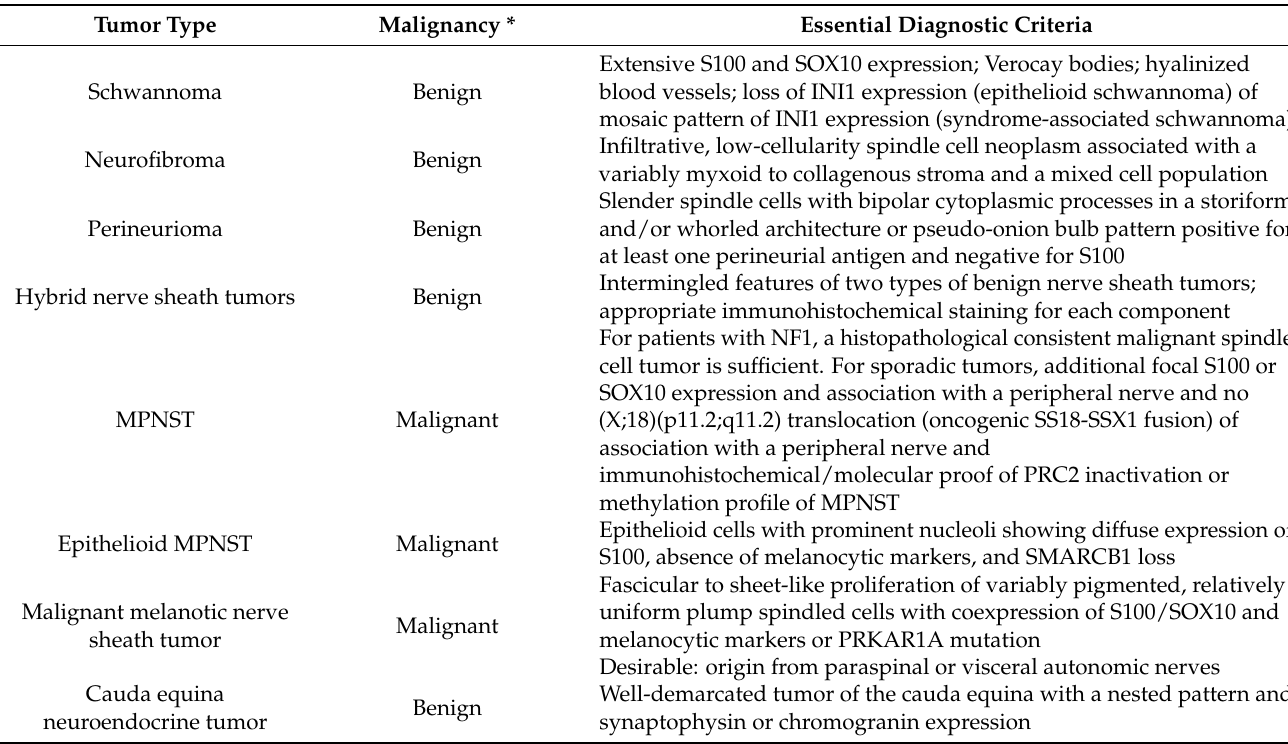
Table 2. Recommendations for pathological diagnosis according to WHO